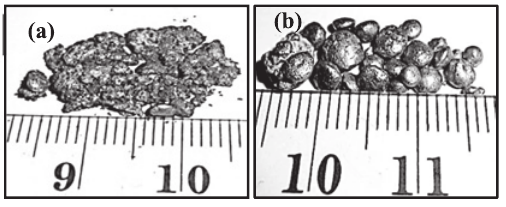
Fig. 10: Nature of metal produced from reduction of slag by (a) coke and (b) Blend 5 at 1500